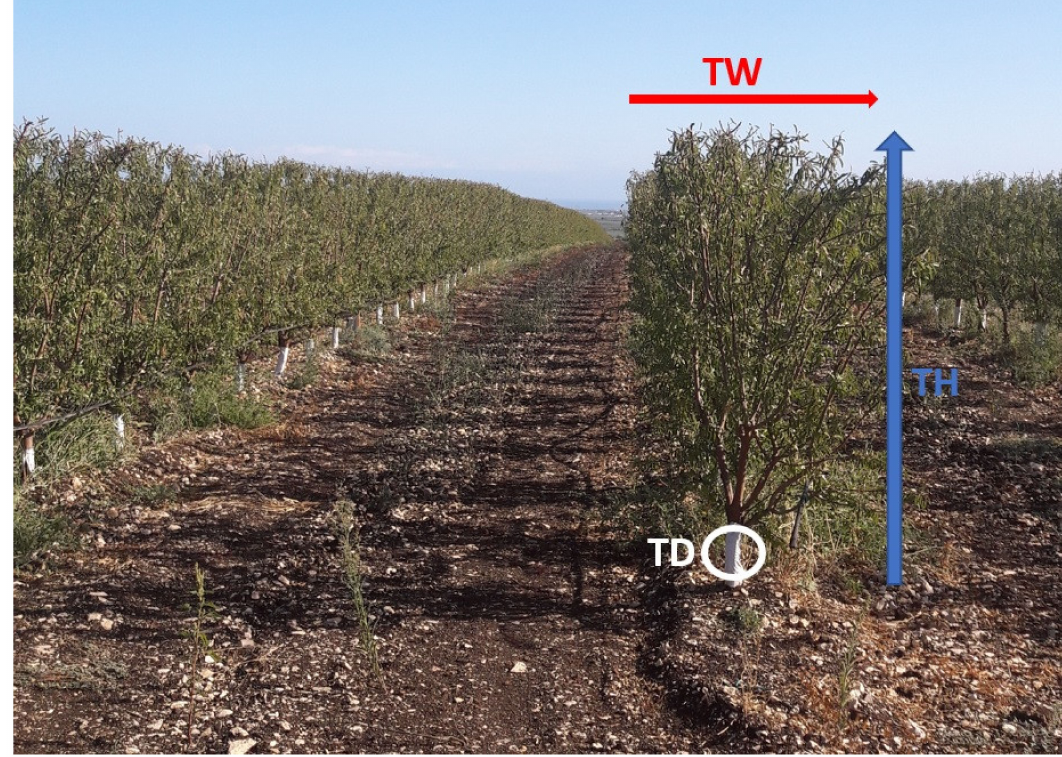
Figure 2. Canopy measurements carried